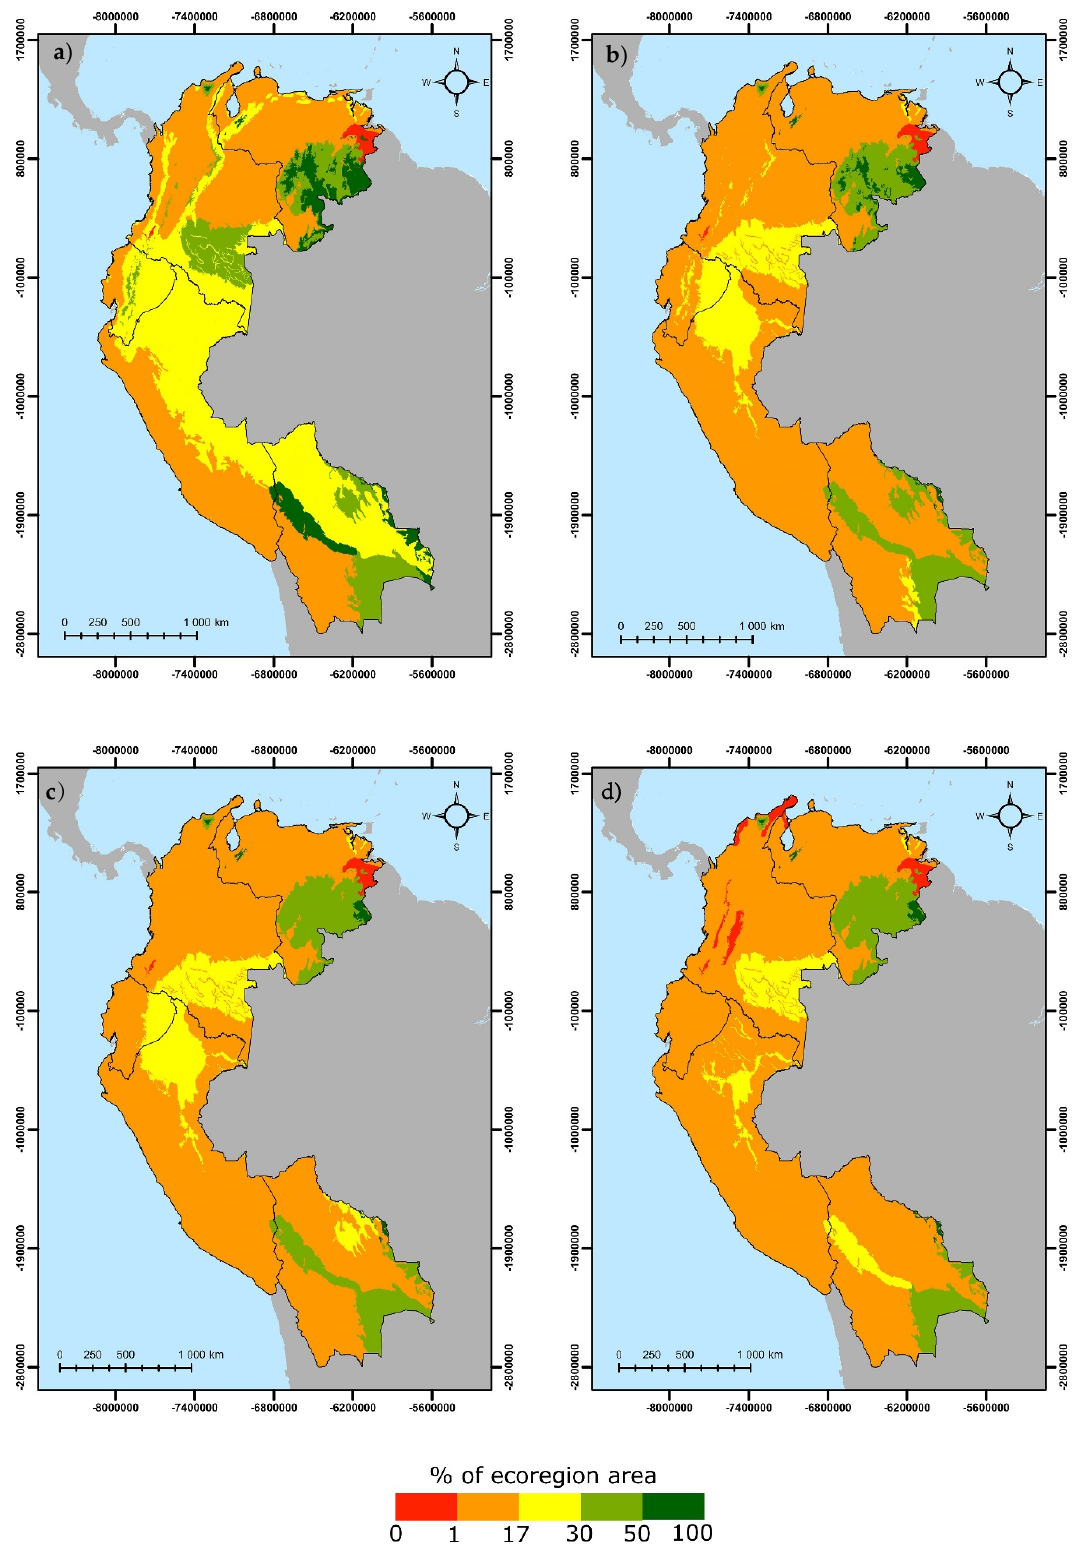
Figure 3. Ecoregion’s PA representation and connectivity (d med = 10 km) in Tropical Andean Countries: ( a ) protected land ( Prot ), ( b ) protected and connected land ( ProtConn Eu ), ( c ) ProtConn CD , ( d ) ProtConn CD without subnational protected areas. The gray background represents continental America. Black lines are the TAC countries’ terrestrial borders. Geospatial data are available for download from https: // doi.org / 10.6084 /